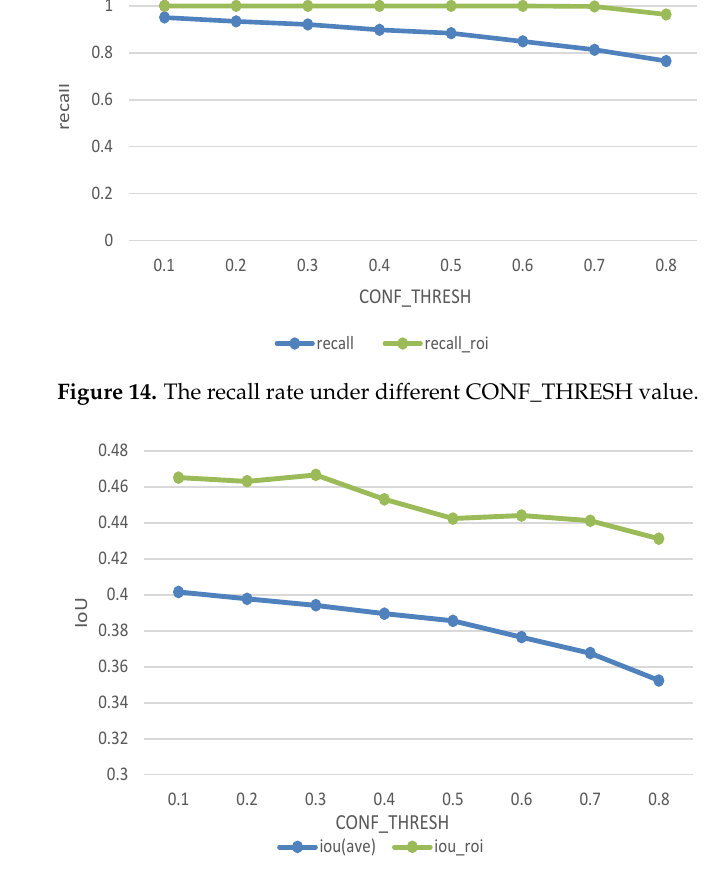
Figure 15. The relationship between CONF_THRESH and